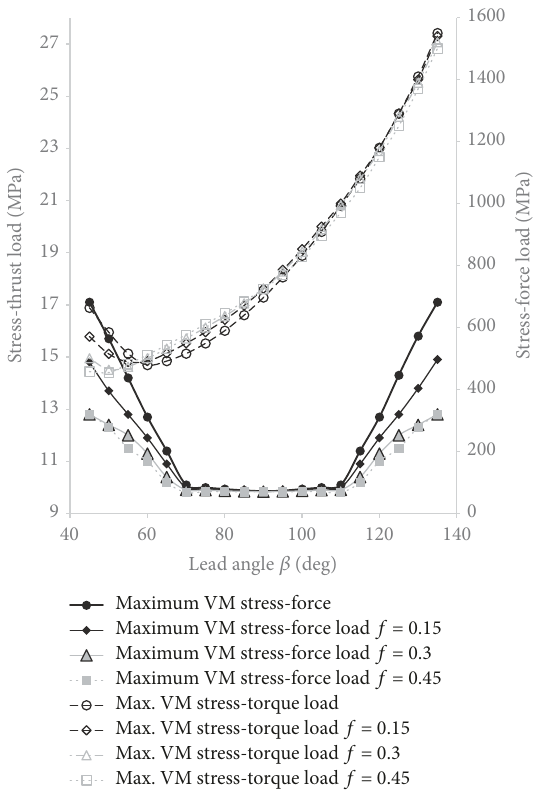
Figure 10: Maximum Von Mises stress for different lead angles underaxialforceload(leftordinate)andtorqueload(rightordinate) calculated by means of FEM model without and with